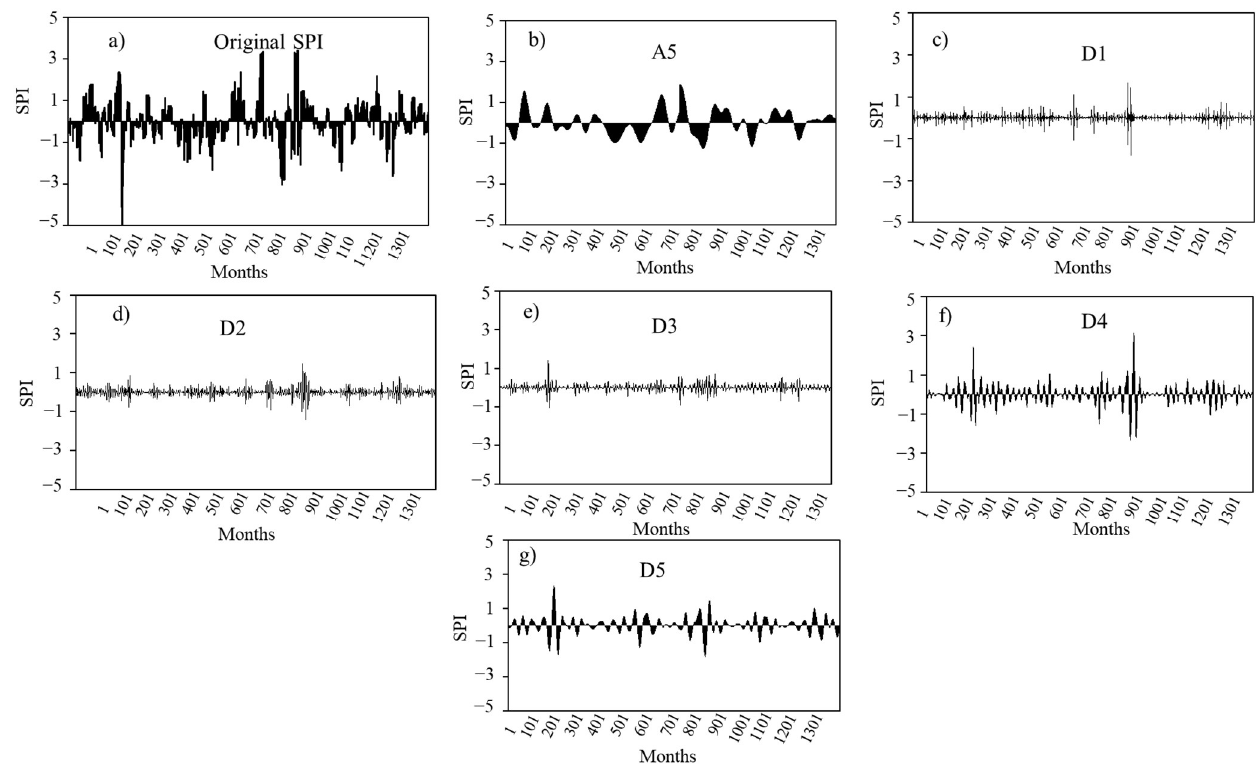
Figure 5. The change in SPI over the study period, where ( a ) represents the original SPI series for SPI-12 and ( b – g ) represent its respective decomposed approximate and detailed components for five levels of decomposition with mother wavelet dbn 7. The Y axis scale is kept the same to highlight the relative difference in the values of detailed and approximate components.